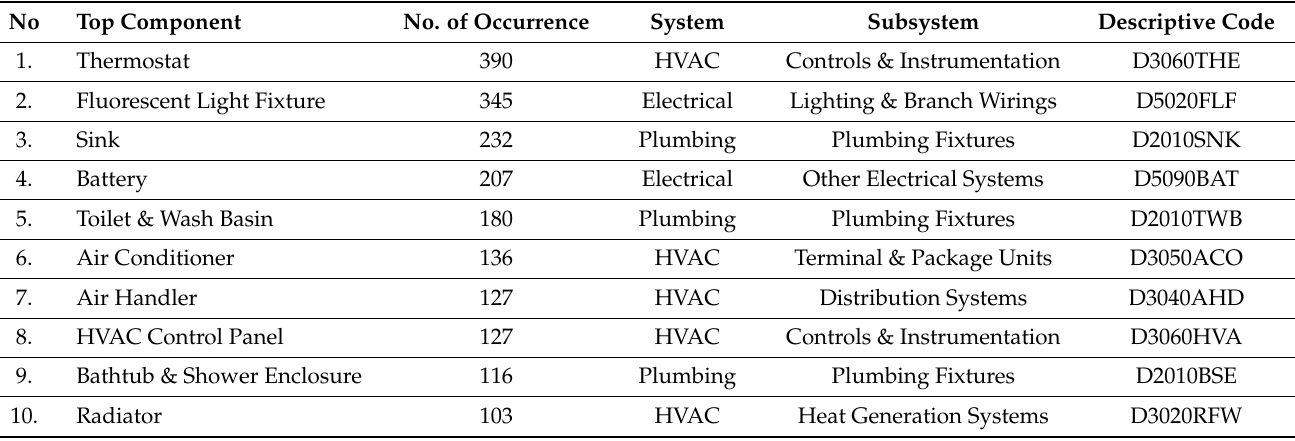
Table 6. Outlier components for